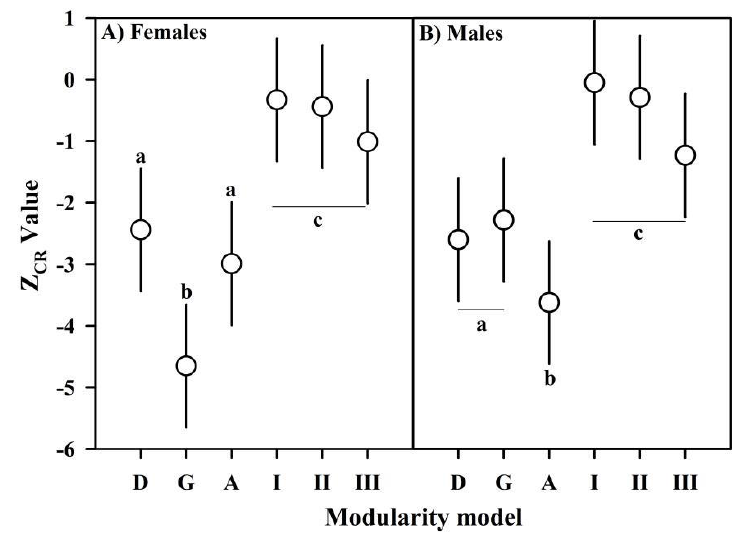
Figure 4. Modular signal based on the CR size effect values (mean Z CR ± 95% CI) for developmental (D), gonadic (G), agonistic (A) and the three anatomical (I – III) modularity models estimated for females ( A ) and males ( B ). Lowercase letters indicate groups of statistically similar models given the relative differences in the modular signal | Ẑ 12 | and overlap of the Z CR distributions ( p -value).